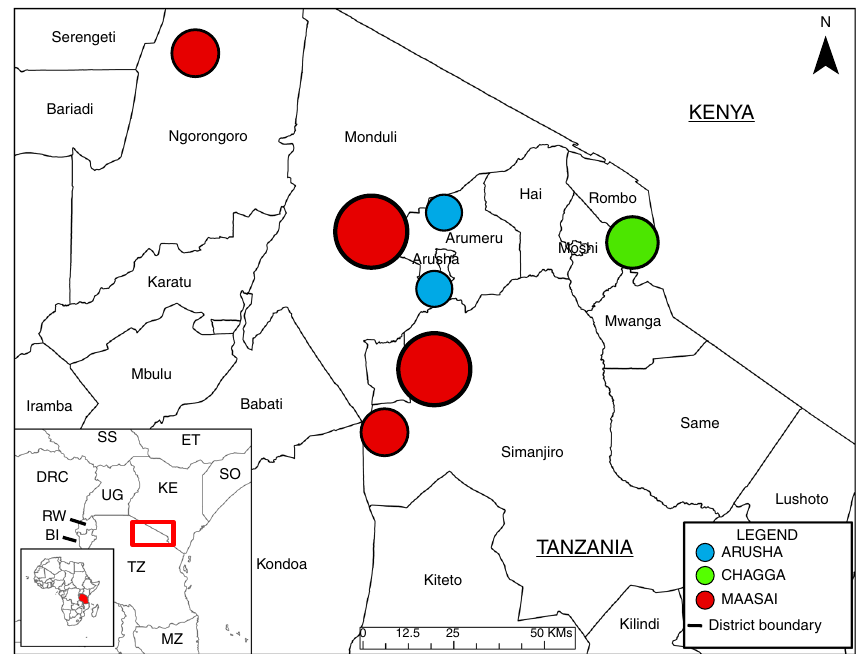
Fig. 1 Map of study area and areas surveyed. Arusha = 103 households, Chagga = 101 households, and Maasai = 201 households. Maps were created using ArcGIS software by Esri. The base map is sourced from Esri and modi fi ed in ArGIS Pro. “ Light Gray Canvas ” [basemap] https://www.arcgis.com/ home/item.html?id = ee8678f599f64ec0a8ffbfd5c429c896. 30 October